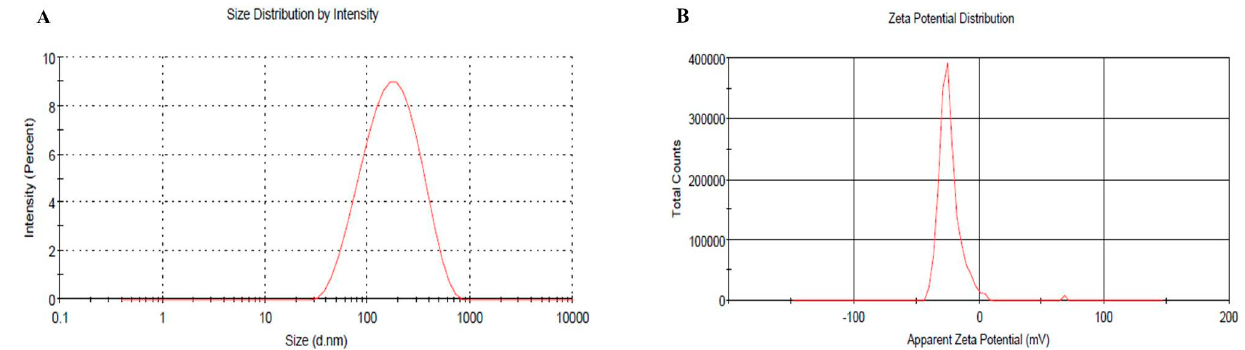
Figure 5. ( A ) Vesicular size distribution curve ( B ) Zeta potential of optimized BRU loaded ethosome.